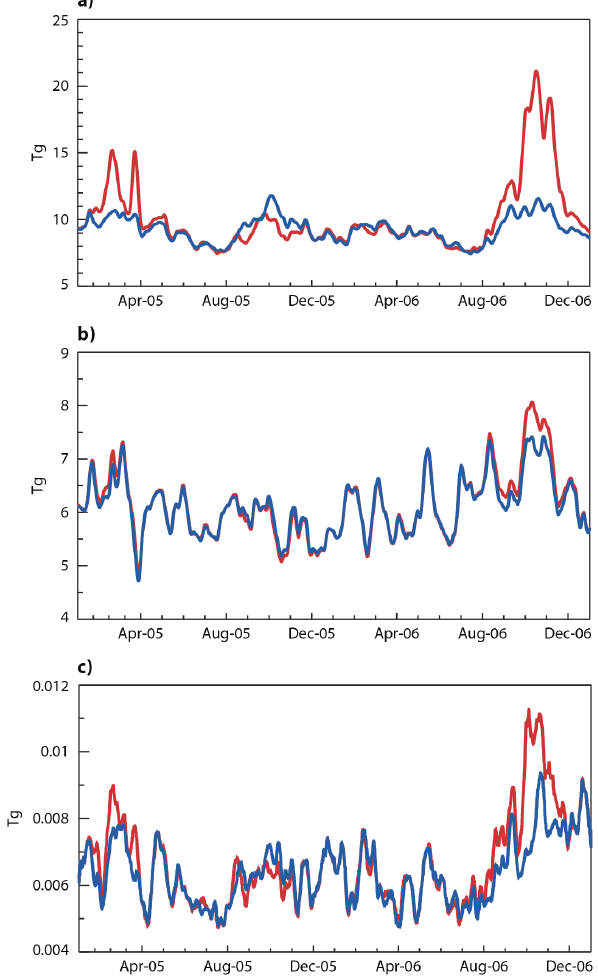
Figure 14. Time series of the tropospheric CO (a) , O 3 (b) , NO 2 (c) burden in Tg from BASE (red) and CLIM (blue) for 2005 and 2006 averaged over the area 10 ◦ N–10 ◦ S, 90 ◦ E–130 ◦